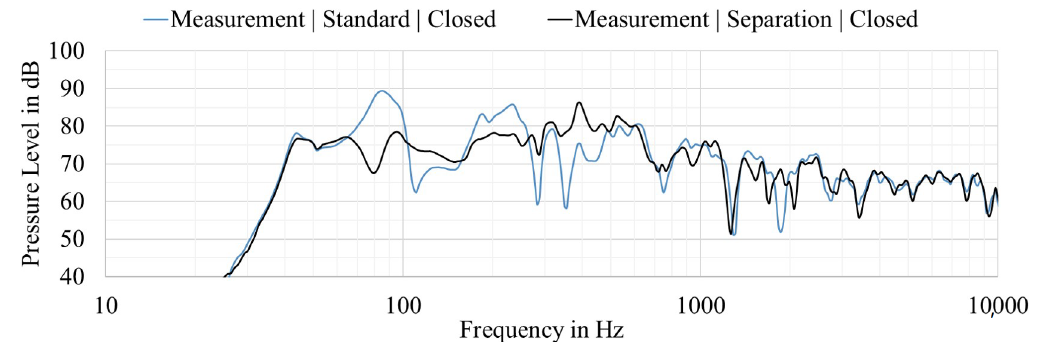
Figure 9. Comparison of the pressure level of the standard volume versus the construction with a separation plate measured at a 1 m distance with 2.83 Vrms input under free-field